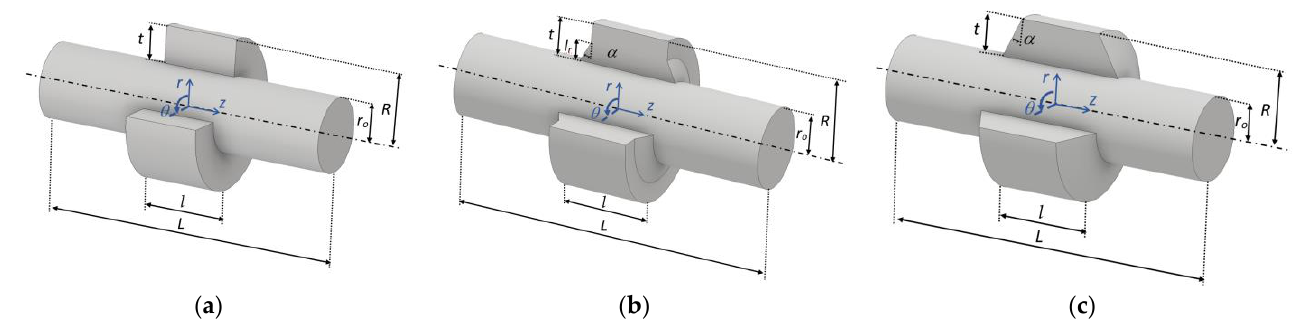
Figure 1. Scheme of a shrink fit with ( a ) a conventional hub; ( b ) a partial chamfered hub; and ( c ) a full – chamfer hub.